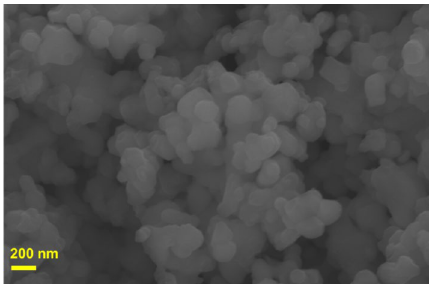
Fig. 6 SEM image of SFM-SDC fuel electrode after 35 h stability studies at 800